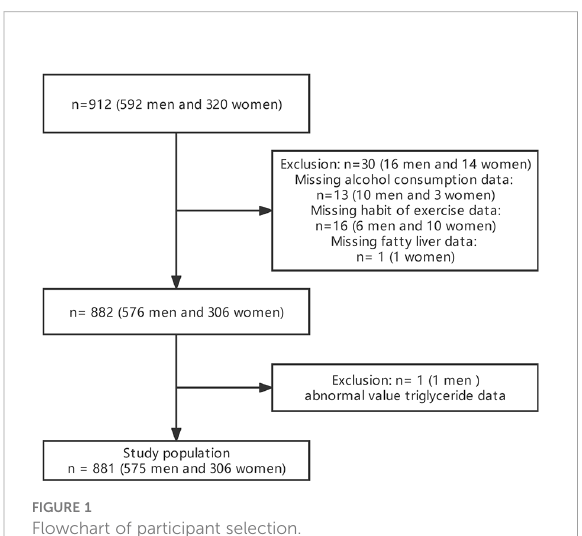
FIGURE 1 Flowchart of participant